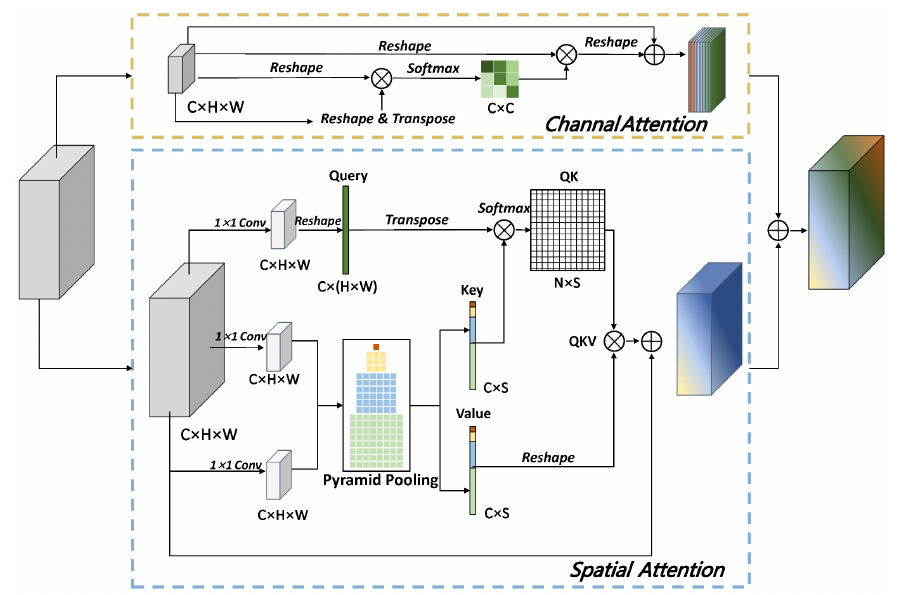
Figure 4. Structure of the attention